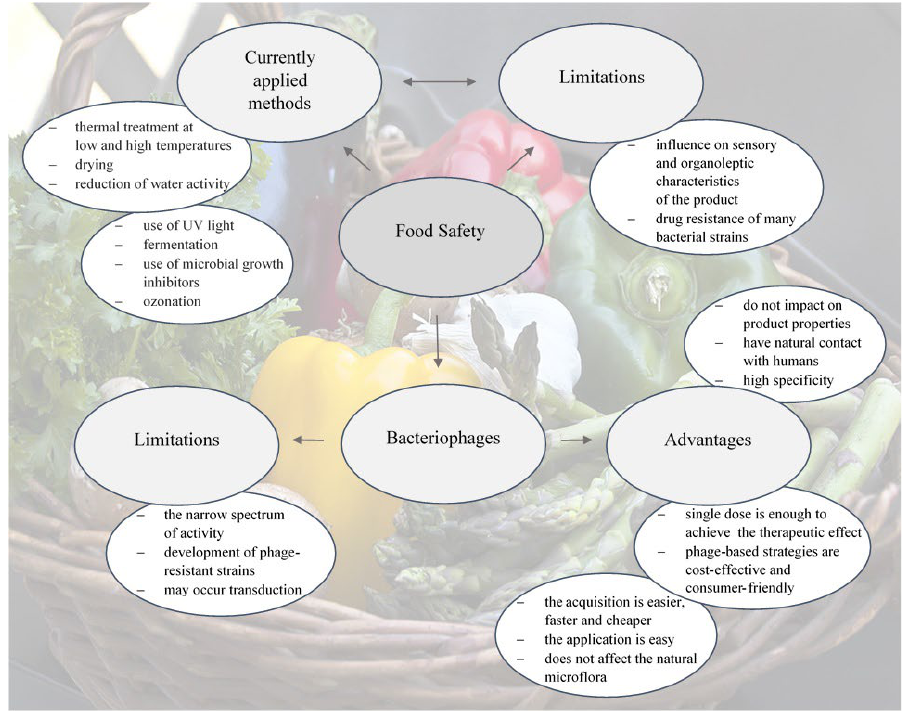
Figure 1. Currently used antimicrobial methods in food safety compared to bacteriophage applica- tion.